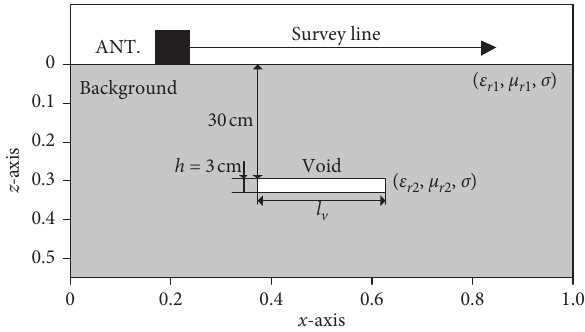
Figure 5: Target echo radar cross